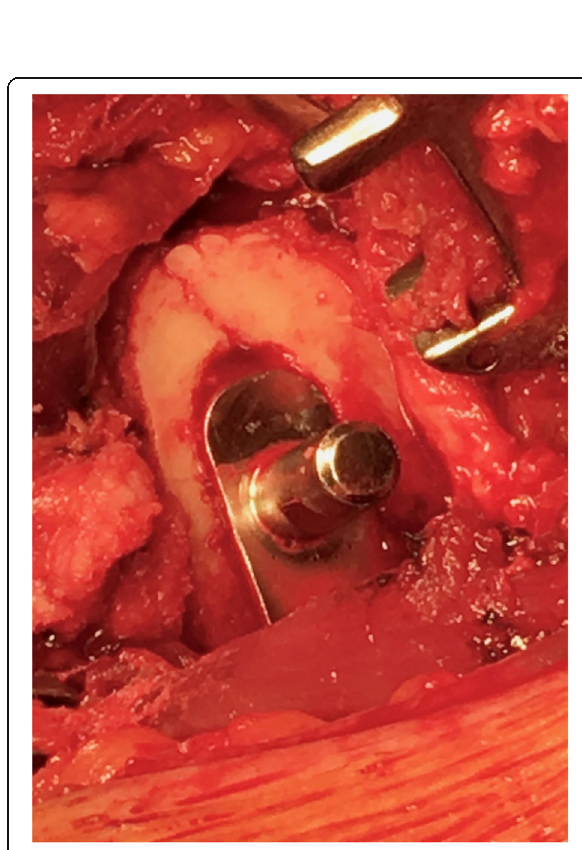
Fig. 3 Intraoperative femoral crack observed during broaching which was fixed using a cerclage wire